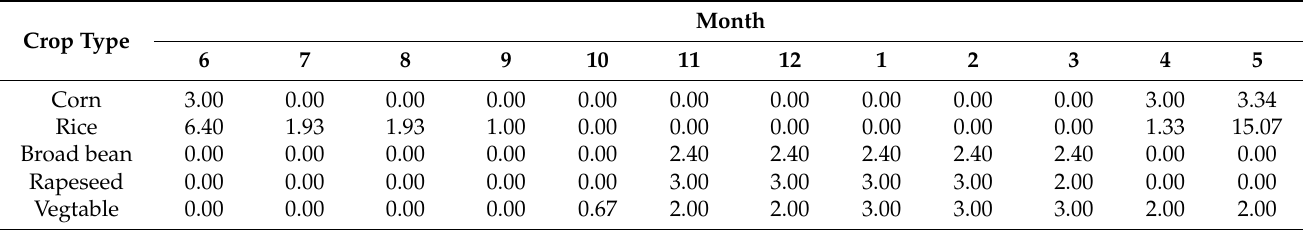
Table 3. The irrigation schedule of the different crops in Erhai Lake Basin unit:m 3